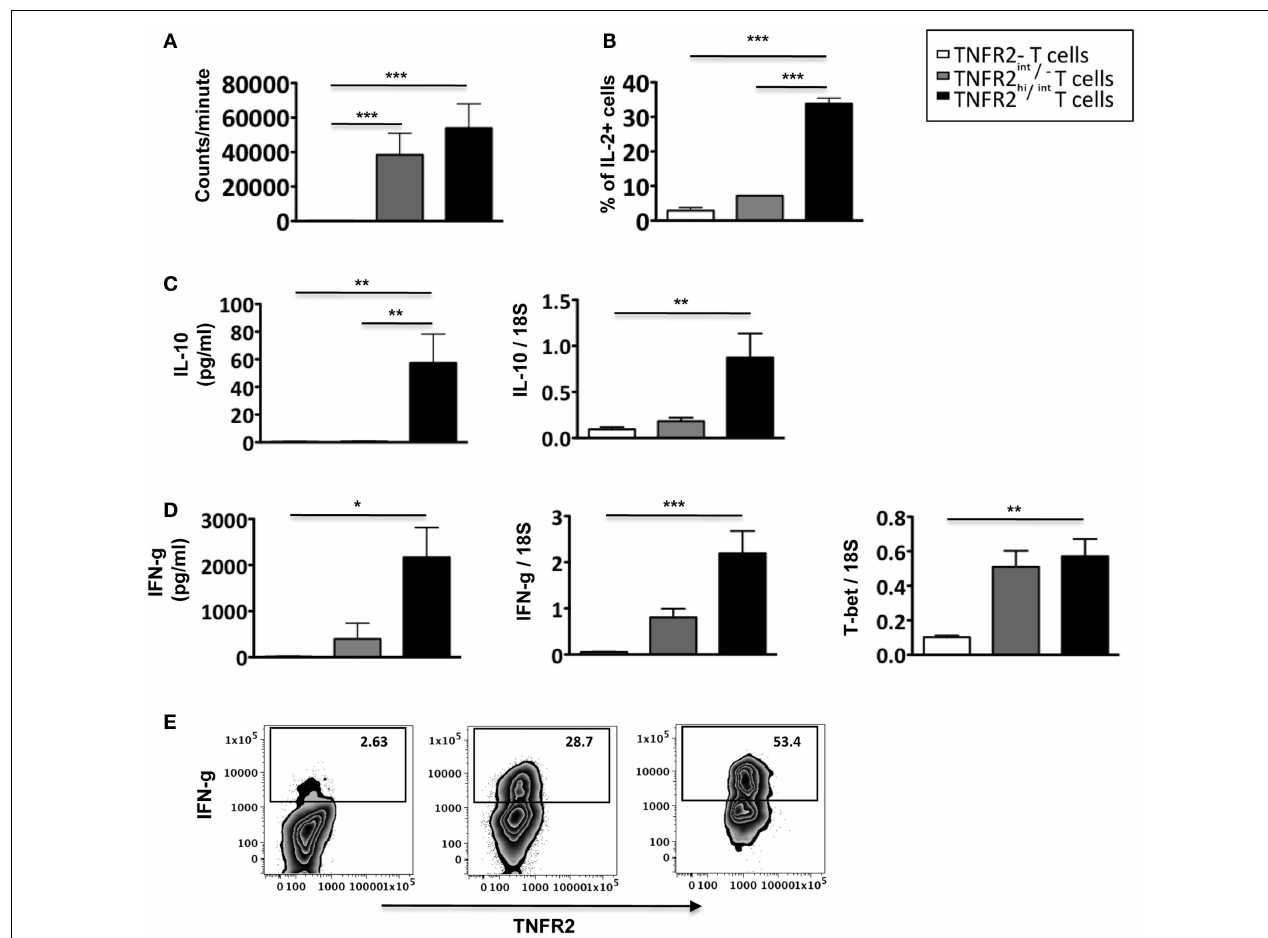
expression levels of IFN-g andT-bet on sortedTNFR2 subsets ( N = 4) (right panel). (E) Total PBMCs were stimulated using CD3/28 to obtain the induced TNFR2 populations. On day 3, cells were further stimulated with PMA/Ionomycin in the presence of Brefeldin A to determine intracellular IFN-g production. Flow cytometry was performed to identify the different induced TNFR2 populations and their IFN-g production was determined. Data is representative of four donors. Kruskal–Wallis with Dunn’s multiple comparison test was used and error bars indicate SEM. Comparison of proliferation, mRNA and cytokine levels: * p < 0.05; ** p < 0.01; *** p <